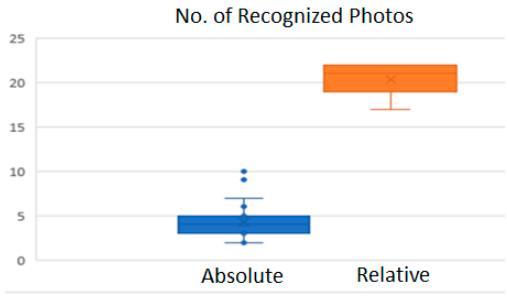
Figure 10. Object reconstructed by relative light.